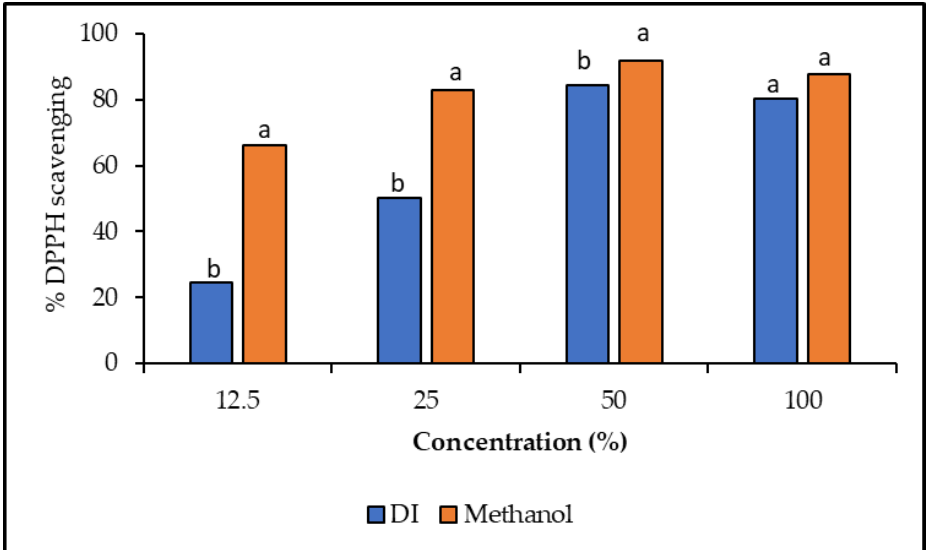
Figure 6. DPPH radical scavenging activity (%). DPPH scavenging activity of different concentrations of DI and methanolic extracts from Azanza garckeana fruit. Results are presented as means ± SD ( n = 3). a,b Means in the same column with different letters are significantly different at ( p < 0.05).